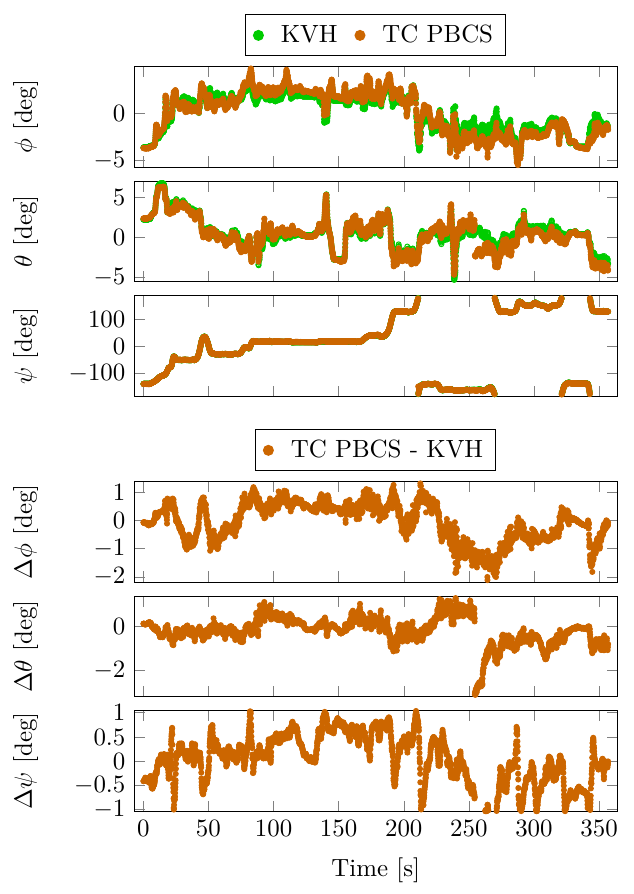
Figure 11. Attitude and attitude angle differences from KVH unit—Case Study